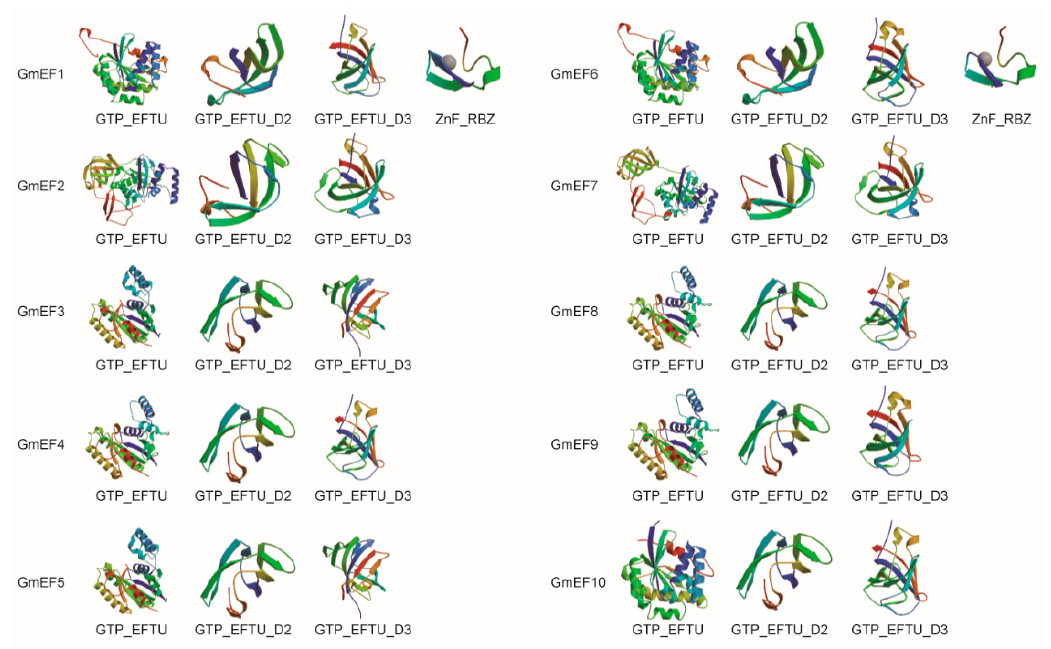
Figure 2. The predicted structures of domains in soybean EF1 α s. The predicted structures of soybean EF1 α s proteins were analyzed by SMART (http://smart.embl-heidelberg.de/) and were drawn online (https://swissmodel.expasy.org/).